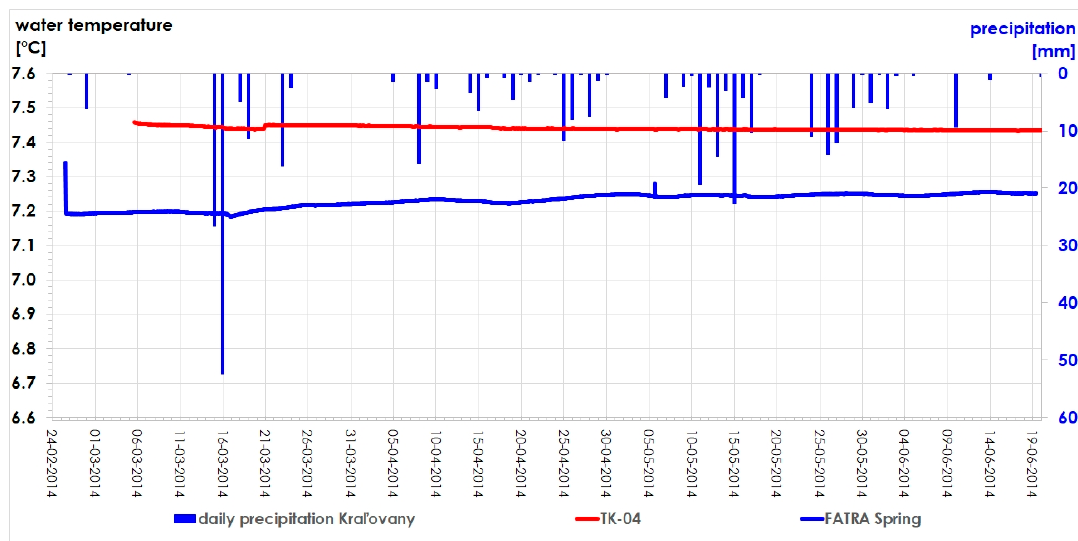
Figure 10. Daily precipitation in Kral’ovany and groundwater temperatures in the Fatra Spring and TK-04 borehole—very limited impact of 15.03.2014–16.03.2014 precipitation event.